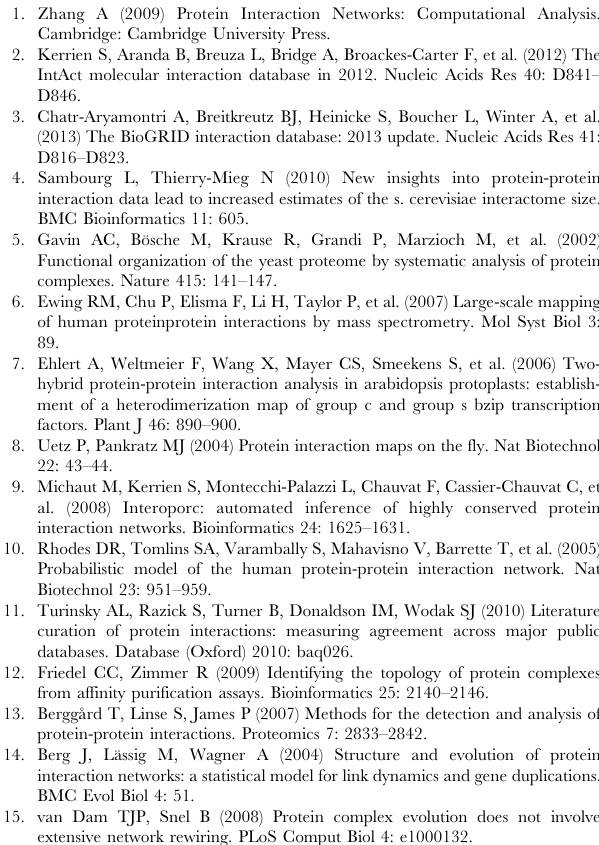
Figure S1 Fraction of interactions derived from low and high-throughput studies. Protein interactions for S. cerevisiae , H. sapiens , D. melanogaster and S. pombe from iRefIndex[33] classified into the categories: derived from low-throughput studies (detected in studies which report between 1 and 10 interactions), derived from mid-throughput studies (detected in studies which report between 10 and 100 interactions), derived from mid-high throughput (detected in studies which report between 100-1000 interactions) and derived from high-throughput studies (detected in studies which report § 1000 interactions). Figure S2 Interactions by detection method. Protein interactions by detection method for S. cerevisiae , H. sapiens , D. melanogaster and S. pombe from iRefIndex[33]. Figure S3 Direct interaction transfer to S. cerevisiae using different ortholog databases. Transfer consistencies of a protein interaction transfer from M. musculus , H. sapiens , S. pombe ,